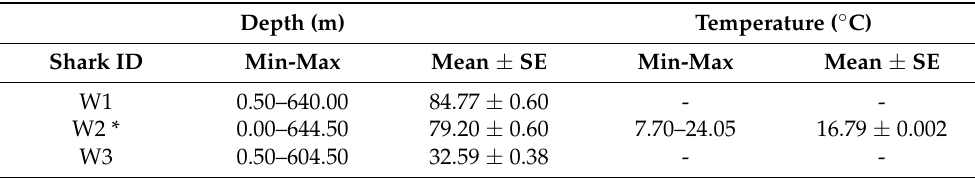
Table 2. MiniPAT archived data of three white sharks ( C. carcharias ) at depth and temperature. * MiniPAT tag recovered. Depth (m) Temperature ( ◦